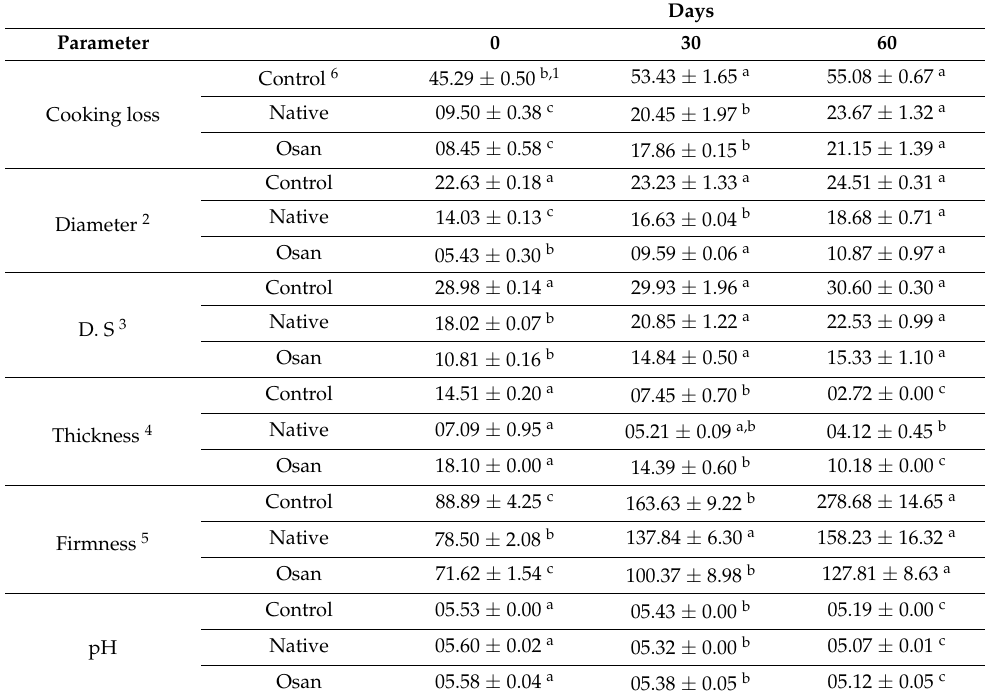
Table 3. Effect of 15% octenyl-succinylated (Osan) corn starch, native starch, and animal fat on the physiochemical characteristics of meat patties after storage at − 20 ◦ C for 0, 30, and 60